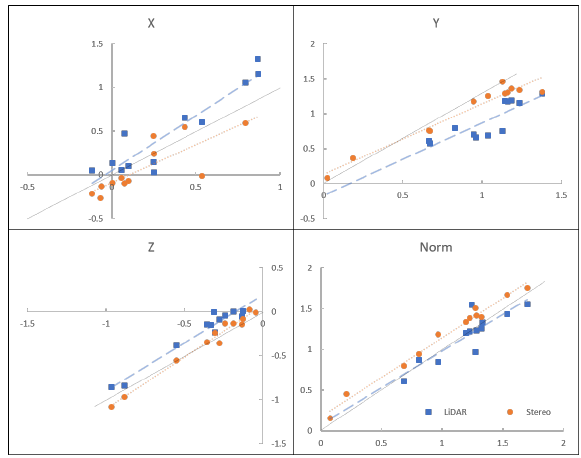
Figure 11. Correlation of DEM and stereo velocity versus GPS measurements.